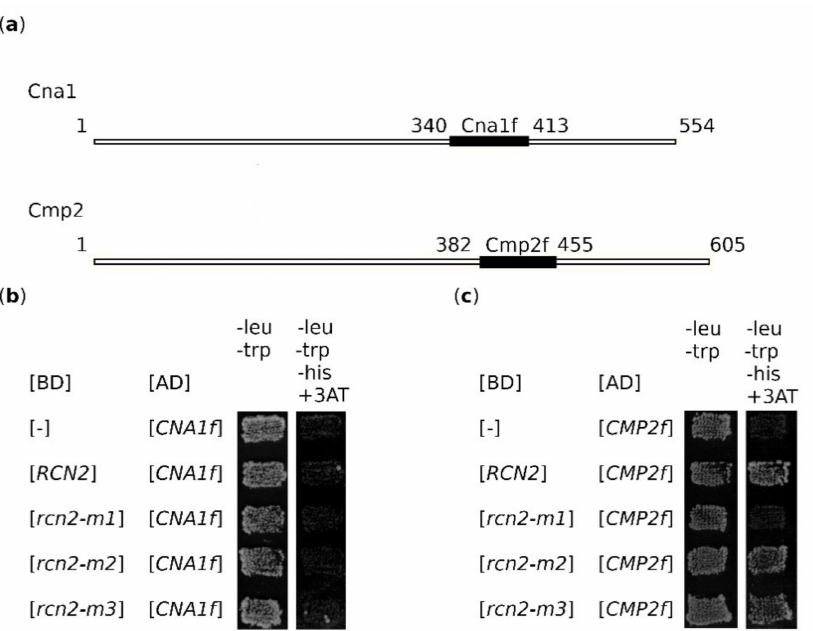
Figure 5. Rcn2 binds to the fragment of Cmp2 involved in the binding of the PXIXIT-type motif in substrates, but not to an analogous region of Cna1. ( a ) Schematic presentation of Cna1 and Cmp2 proteins with the indicated fragments (Cna1f; aa 340–413 and Cmp2f; aa 382–455) used to study interaction with Rcn2. ( b ) Rcn2 and Cna1f do not interact in the two-hybrid system. ( c ) Rcn2 and Cmp2f interact in the two-hybrid system. BD, DNA-binding domain; AD, activating